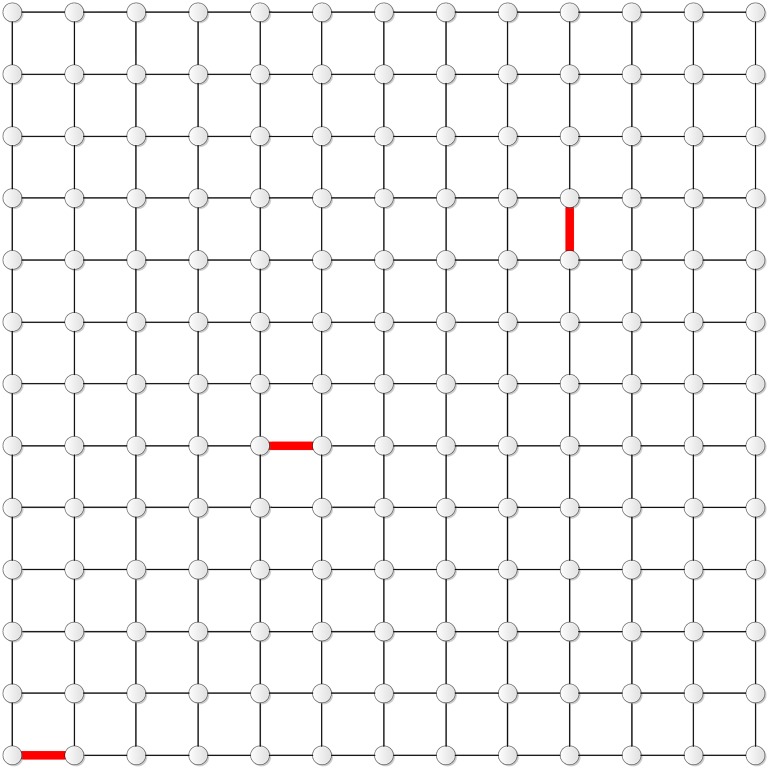
The distribution of the three edges in T13.